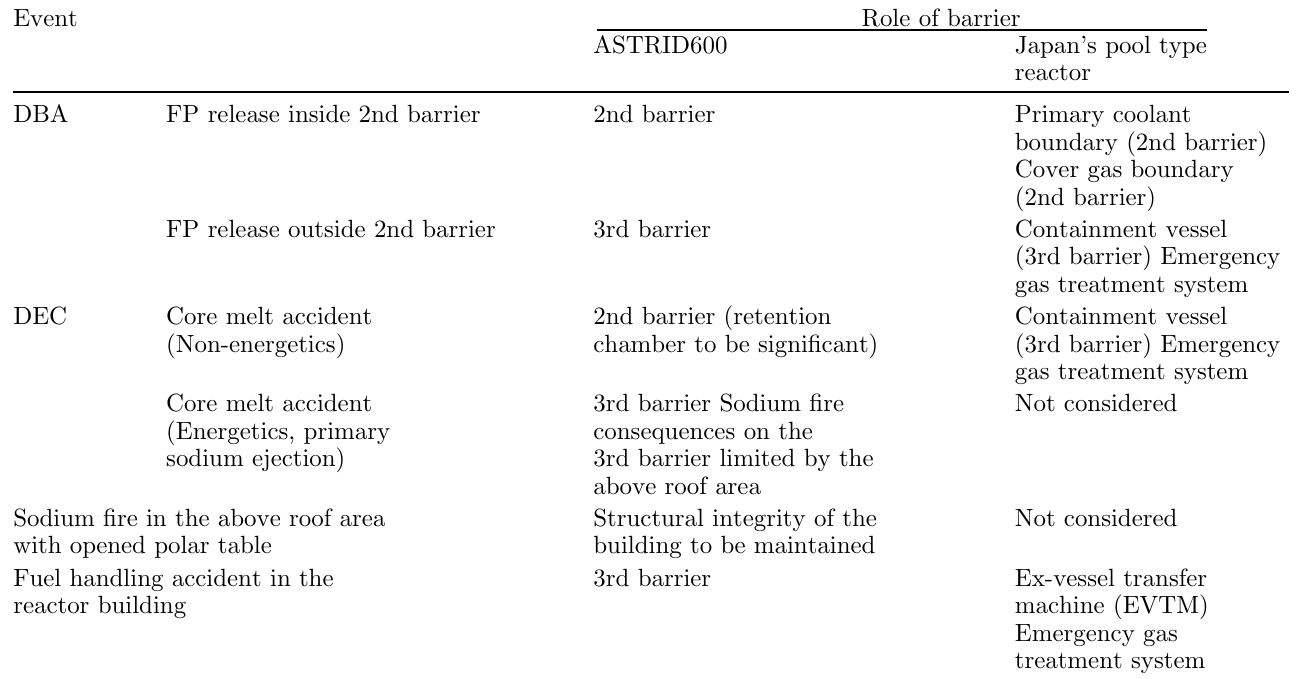
Table 3. Role of barriers